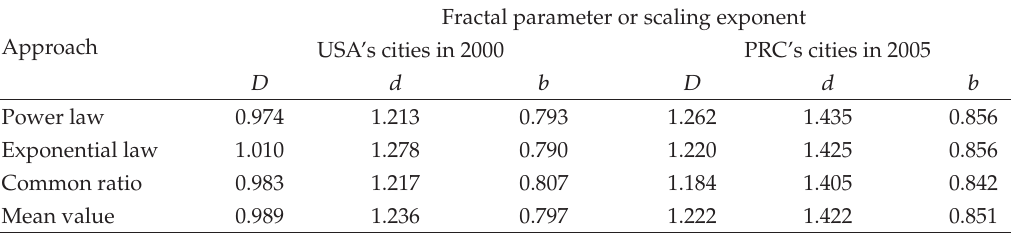
Table 5: The collected results of the fractals parameters and scaling exponents of the hierarchies of the USA and PRC